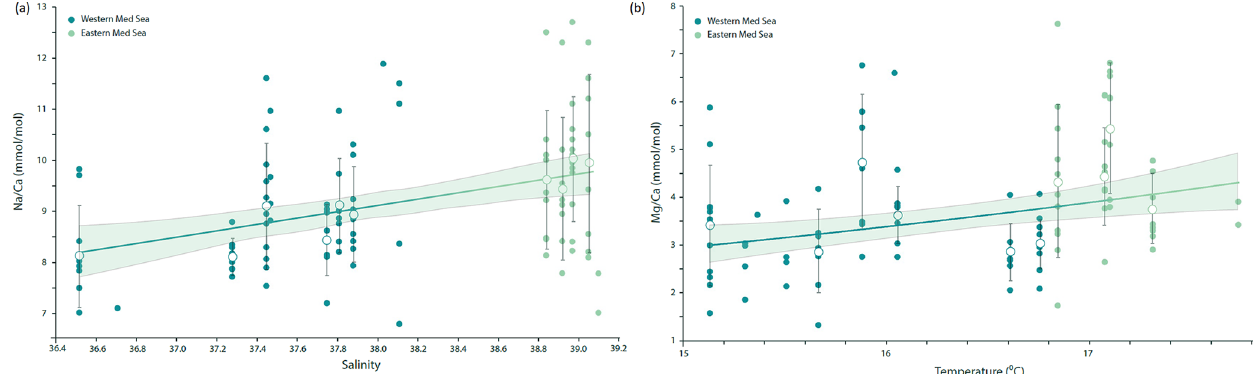
Figure 4. (a) Na / Ca measured in G. ruber albus F-chambers collected as living specimens from the eastern and western Mediterranean Sea correlates well with local salinity ( p value < 0.001, Na / Ca = 0 . 60 × S − 13 . 84), even though a large natural spread of the elemental composition around the mean values per station exists ( R 2 = 0 . 13). For salinities with more than five individual Na / Ca measurements, hollow circles with whiskers indicate average values and standard deviations respectively. (b) Mg / Ca in F-chambers of G. ruber albus specimens collected from the water column of the Mediterranean Sea is positively correlated with sea surface temperature and can be described with the following exponential relationship: Mg / Ca = 0 . 37 × exp(0 . 14 × T ). For temperatures with more than five individual Mg / Ca measurements, hollow circles with whiskers indicate average values and standard deviations respectively. Regression lines were calculated using all individual data points.